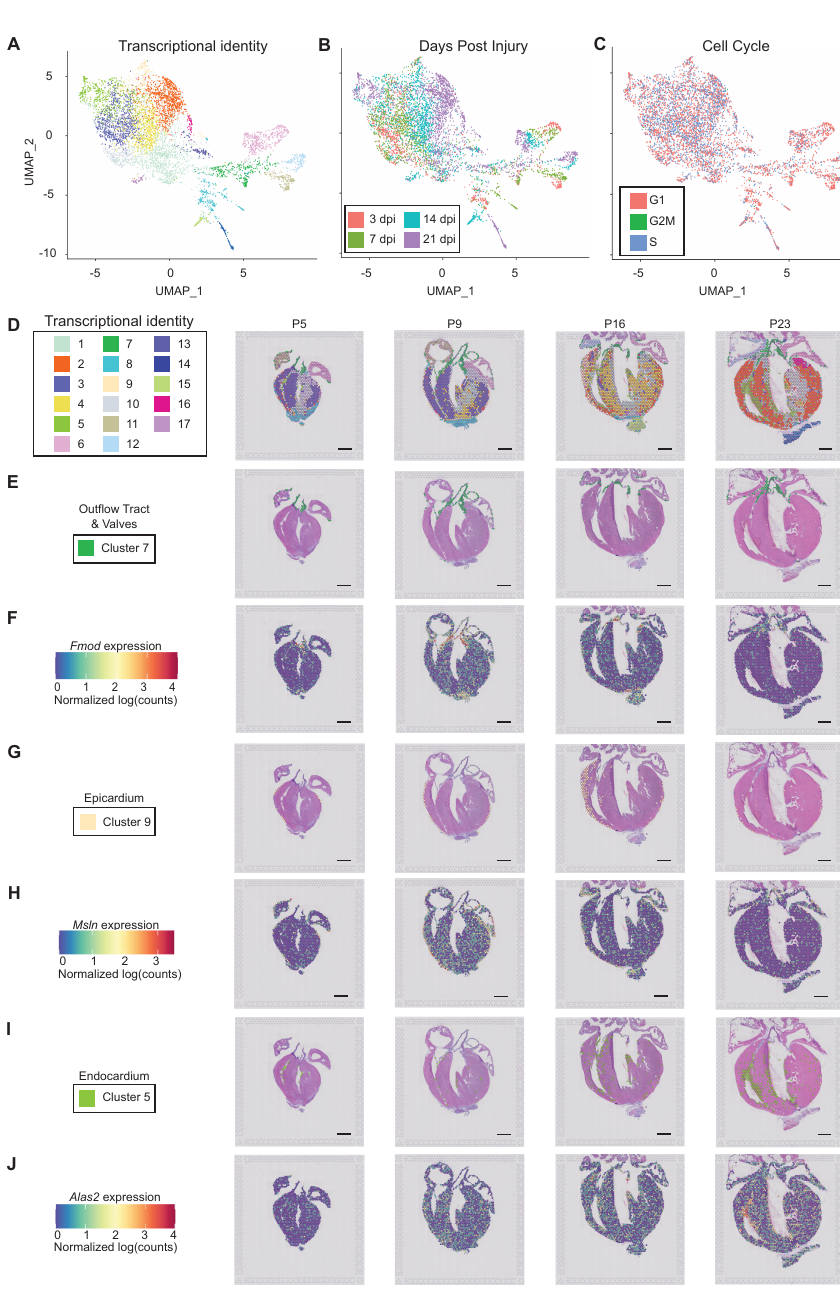
Figure 3. Spatial transcriptomics reveals spatially restricted gene programs in postnatal mouse heart regeneration at near single-cell resolution. ( A ) Uniform manifold approximation and projection